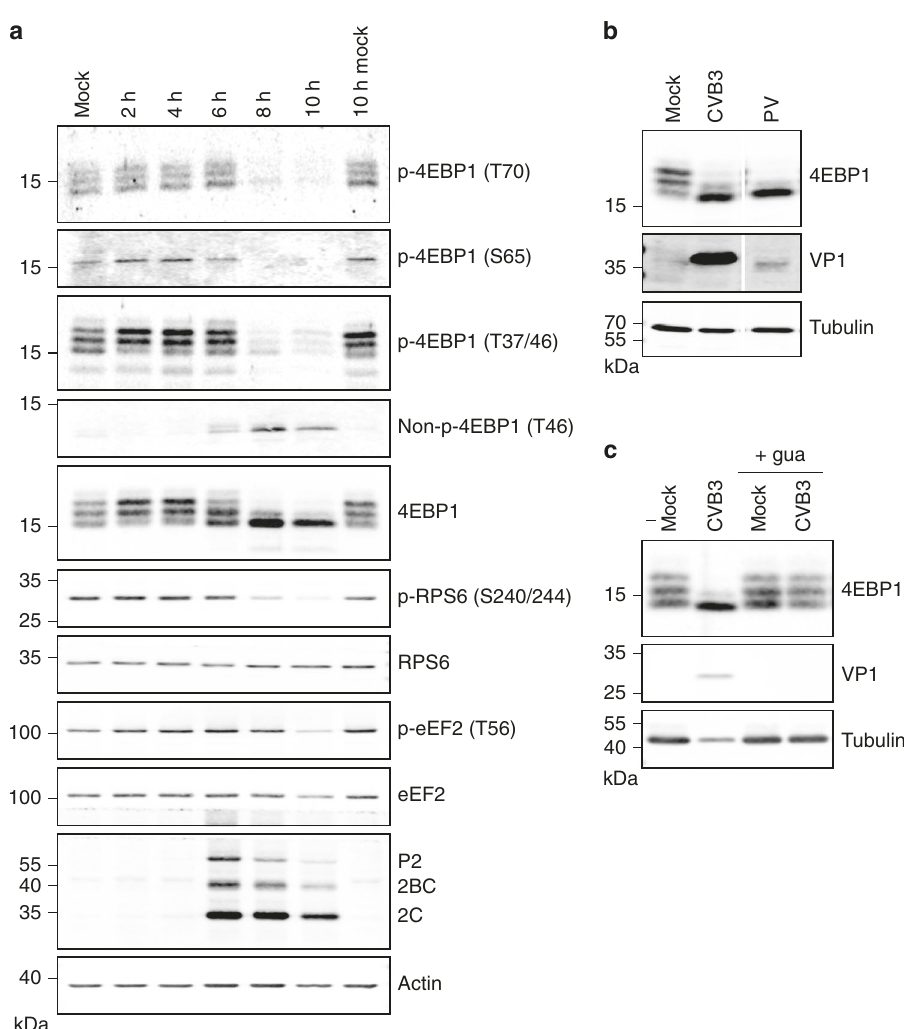
Fig. 4 Analysis of the activity of mTORC1 in enterovirus-infected cells. a Western blot analysis of infected cells showing mTORC1 inhibition. HeLa cells were infected with CVB3 at MOI 50 as in Fig. 1a, lysed at different time points and the lysates were analysed by Western blotting using antibodies that recognise proteins in the mTORC1 signalling pathway or speci fi c phosphorylated forms of these proteins. The different 4EBP1 bands represent differentially phosphorylated forms of the protein, whereby slower migrating bands represent more extensively phosphorylated forms of the protein. An antibody against viral protein 2C, which also detects the 2C cleavage precursor proteins 2BC and P2, serves as a control to show infection. Actin is used as a loading control. The 10 h infected samples contain less material due to cytopathic effect and the ensuing detachment of part of the infected cells. b HeLa cells were infected with CVB3 (enterovirus B species) or poliovirus (PV, enterovirus C species) at MOI 25 and Western blot analysis of 4EBP was performed as in panel ( a ). An antibody against the capsid protein VP1 of CVB5, which is highly cross-reactive to CVB3 VP1 and to a lesser extent also recognises PV VP1, was used as an infection control. Tubulin was used as a loading control. c HeLa cells were infected with CVB3, treated with 2 mM of the replication inhibitor guanidine as indicated, lysed after 8 h, and processed for Western blot analysis as in ( a ). mTORC1 inhibition is evident from a collapse of the 4EBP1 bands into the least phosphorylated lower band only when cells were infected with CVB3 in the absence of guanidine. Source data are provided as a Source Data fi le for all